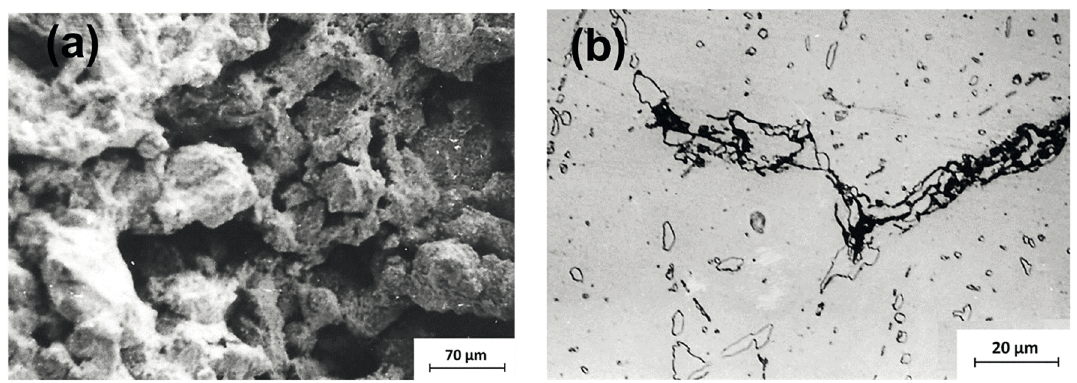
Figure 4. Long time creep fracture for SS1 steel tested at 800° C with σ = 75 MPa; t